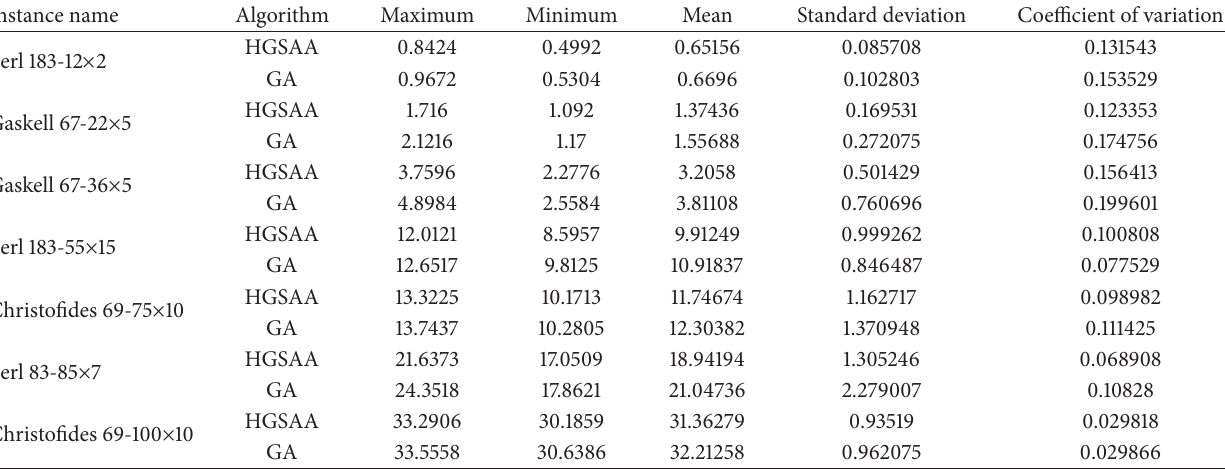
Table 5: CPU time (seconds) for calculation of two